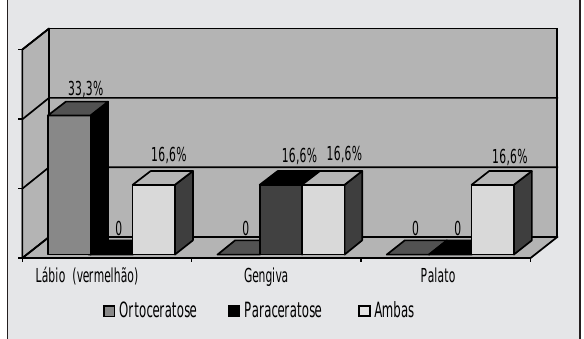
Figura 5 – Avaliação da camada córnea das seis biópsias de líquen plano oral de áreas normalmente